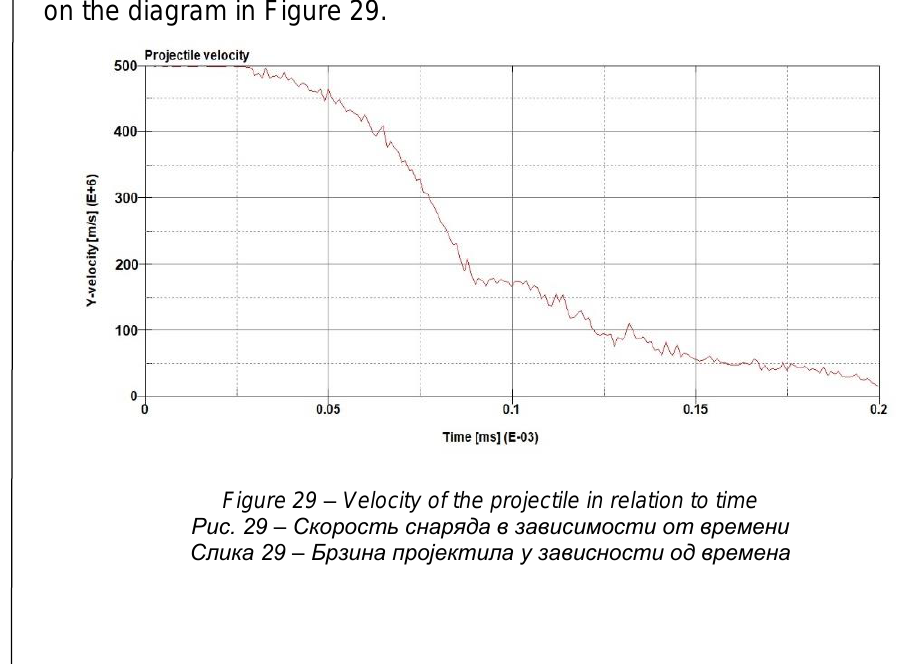
Figure 29 – Velocity of the projectile in relation to time Рис. 29 – Cкорость снаряда в зависимости от времени Слика 29 – Брзина пројектила у зависности од